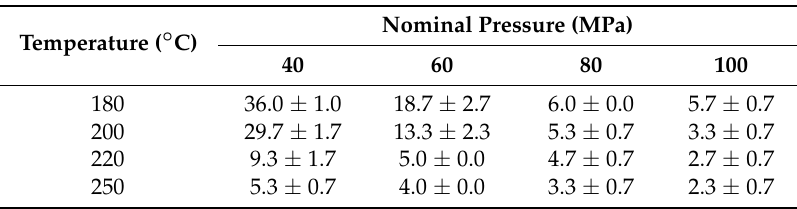
Table 3. Anti-scuffing time duration of the CKS/Fe pair *.